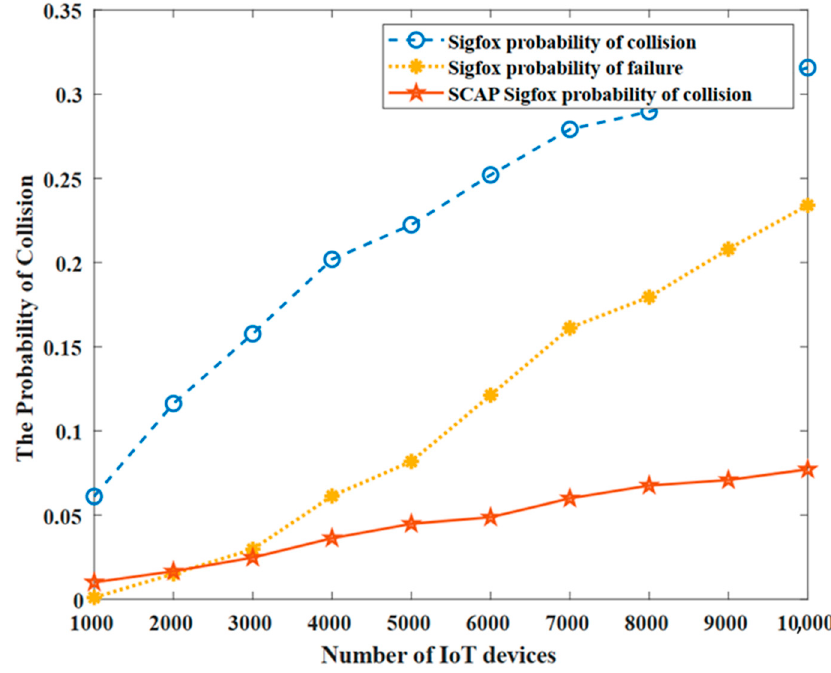
Figure 8. The probability of collision and failure.